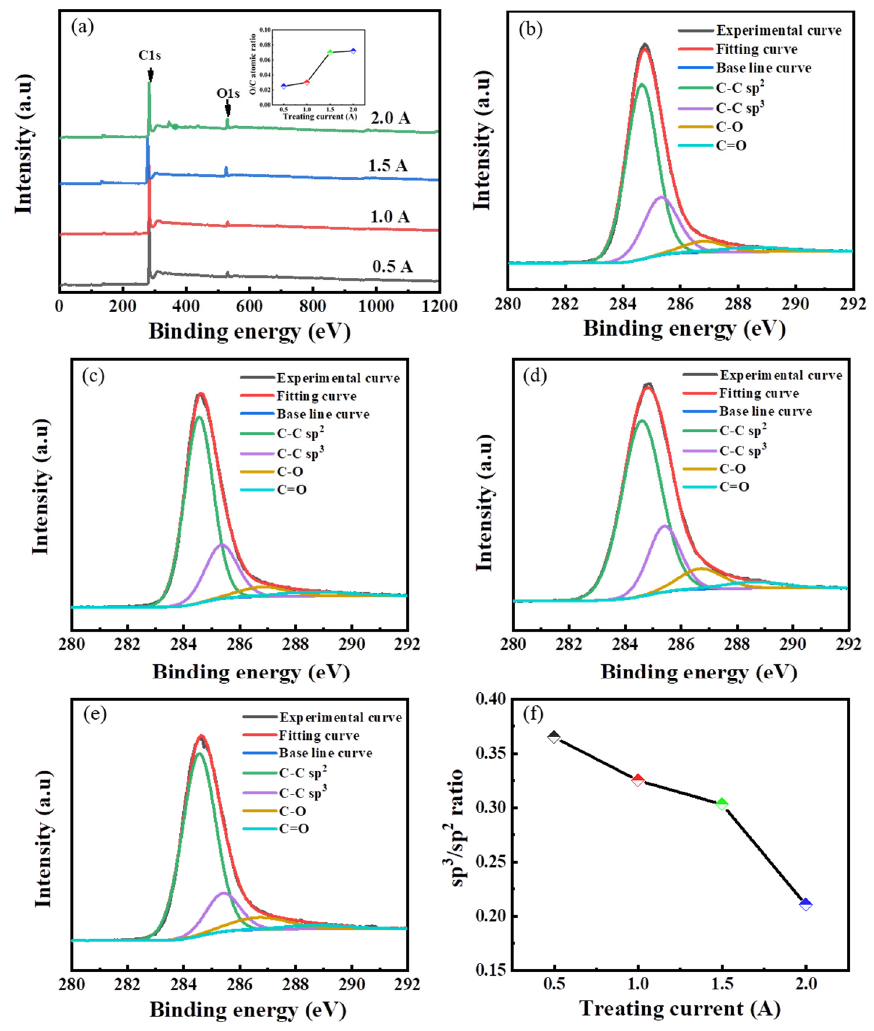
Figure 3. XPS of UHMWPE substrates treated with different carbon plasma currents: ( a ) wide XPS spectrum (the inserted picture is the atomic ratio of O/C), ( b – e ) the fitting results of the C1s spectrum with treatment currents of 0.5, 1.0, 1.5 and 2.0 A, respectively, ( f ) the sp 3 /sp 2 ratio value.